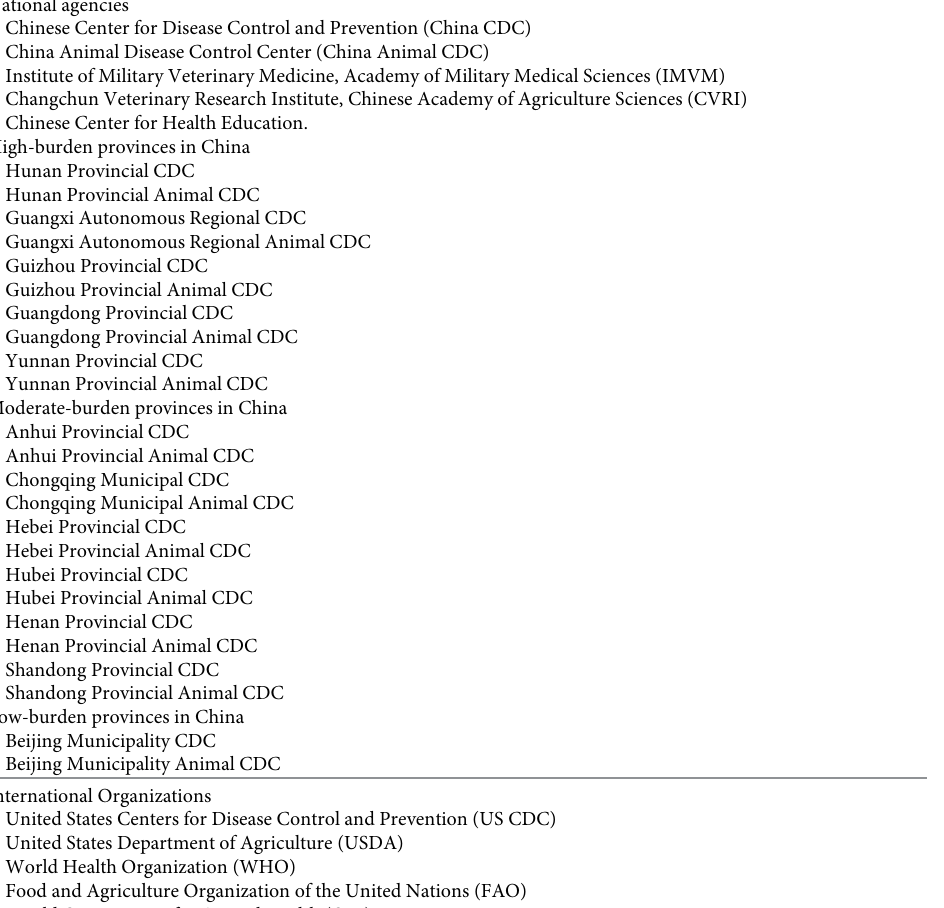
Table 1. Agencies � participating in the Stepwise Approach towards Rabies Elimination (SARE) assessment, Bei- jing, China, March